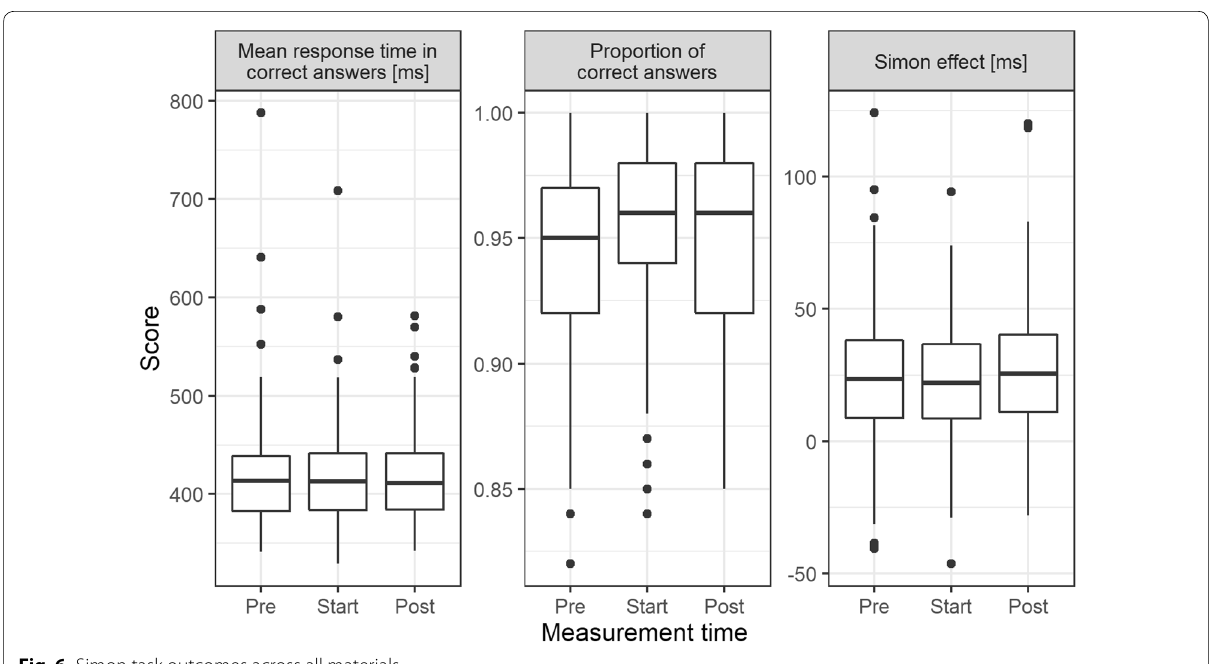
Fig. 6 Simon task outcomes across all materials